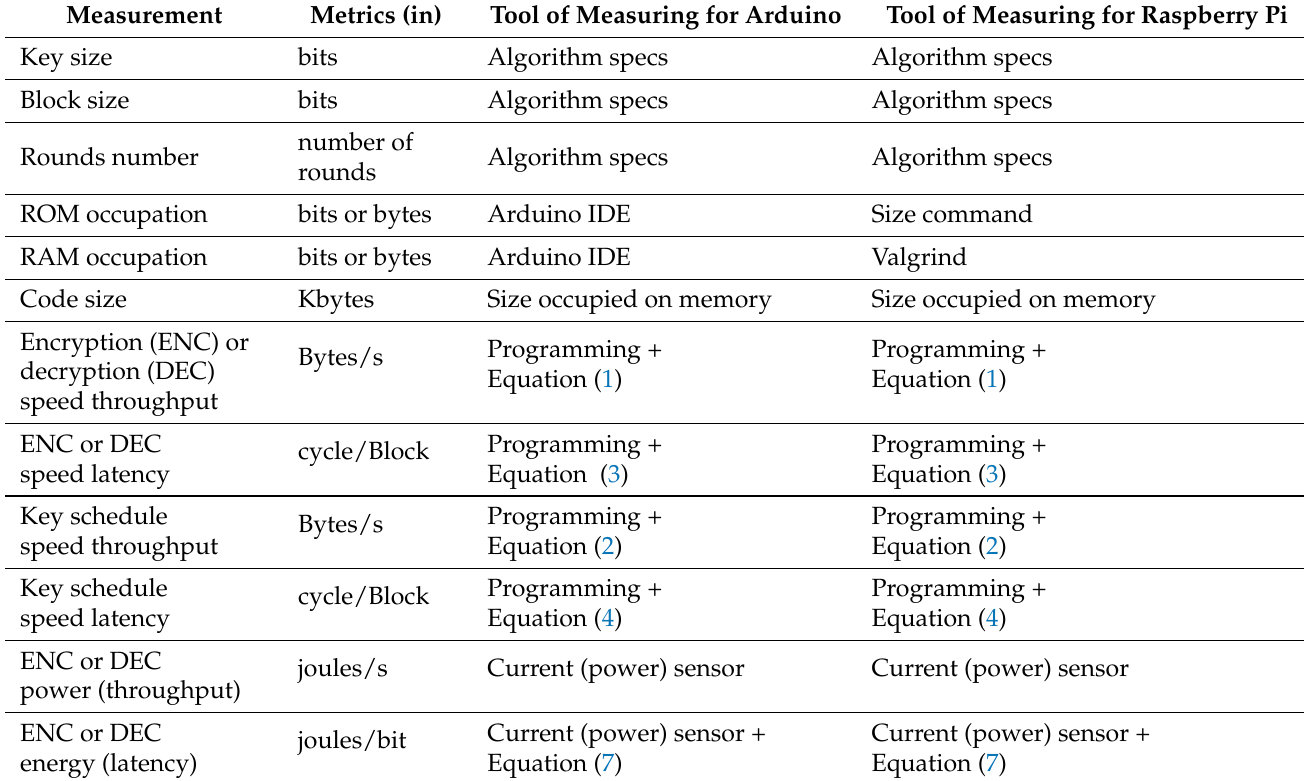
Table 3. Measurement of LWC and their